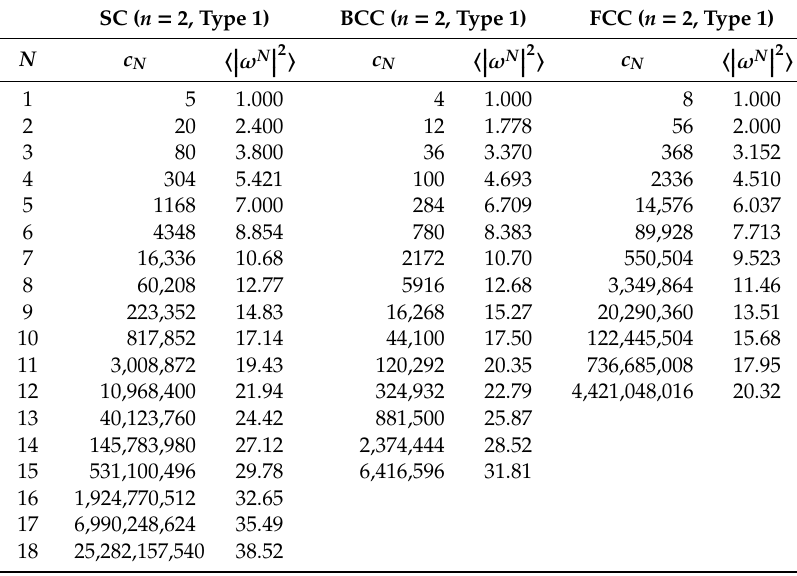
Table A3. Properties of SAWs on the SC, BCC and FCC lattices with two layers between the confining plates ( n = 2, Type 1).